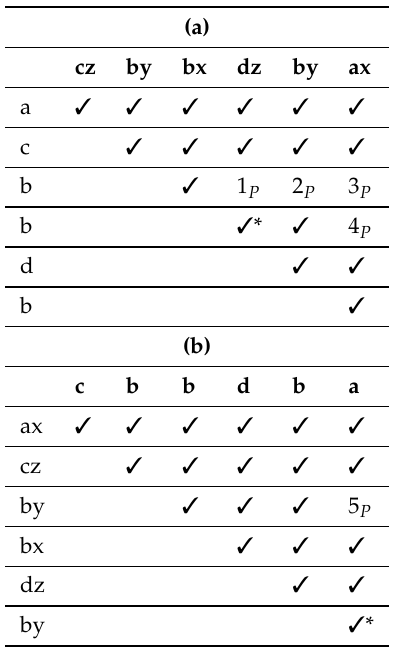
Table 15. MR-I results for precedence constraints: ( a ) activation; and ( b )